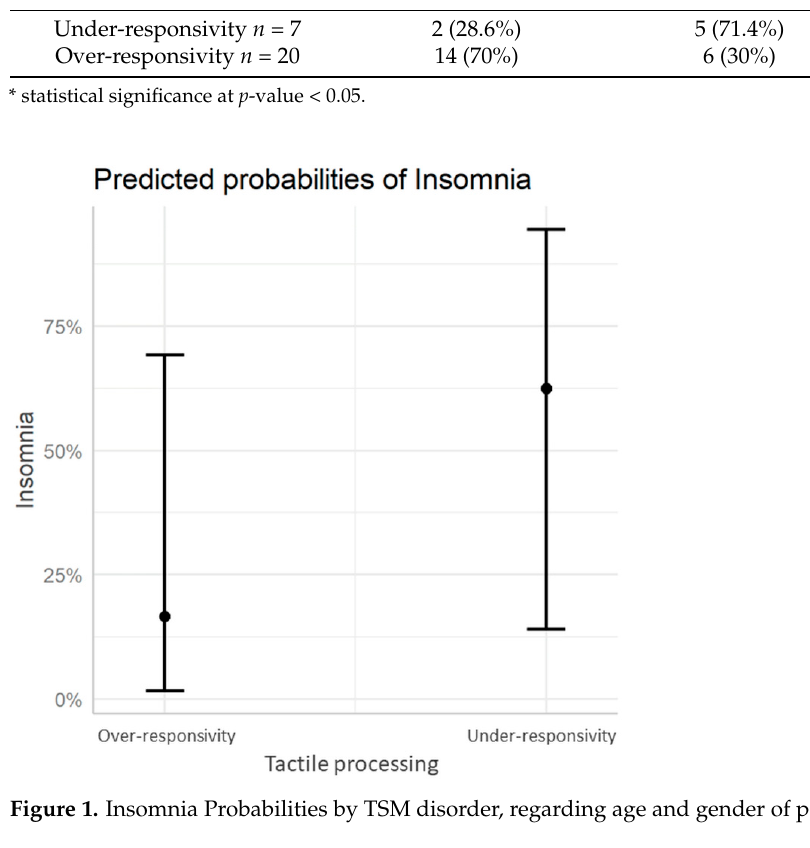
Figure 2. Athens Insomnia Scale (AIS) score by means of tactile processing disorders. Boxes repre ‐ sent medians and bars represent interquartile ranges ( p = 0.51). In the logistic regression model (enter method), we found that the AIS score did not predict tactile under ‐ responsivity (b = 0.16, SE = 0.13, Wald = 1.59, p = 0.21, and OR (odds ratio) = 1.18, with 95% CI = 0.9117 to 1.5317). 4. Discussion The present study examined whether TSM disorders might be linked to insomnia prevalence in ASD individuals. We hypothesized that sleep disorders in children with